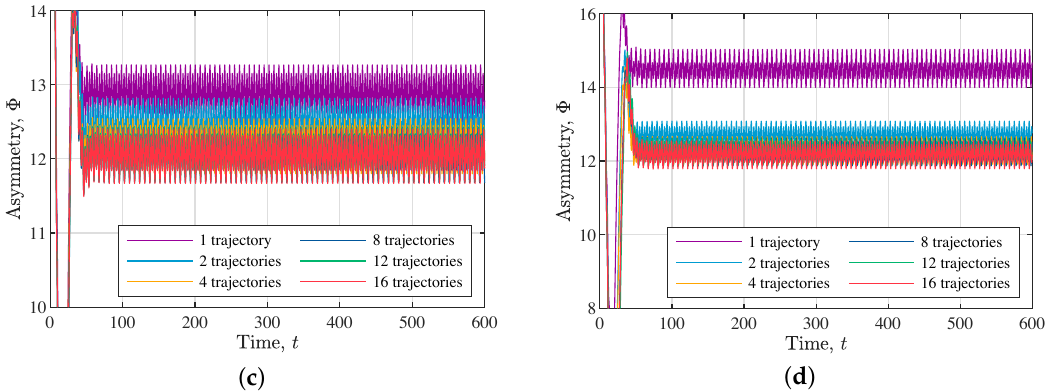
Figure 14. History of the asymmetry function under the control laws over the number of the trajectories of the training datasets. ( a ): the control law (SF-1), ( b ): the control law (SF-2), ( c ): the control law (OF-1), ( d ): the control law